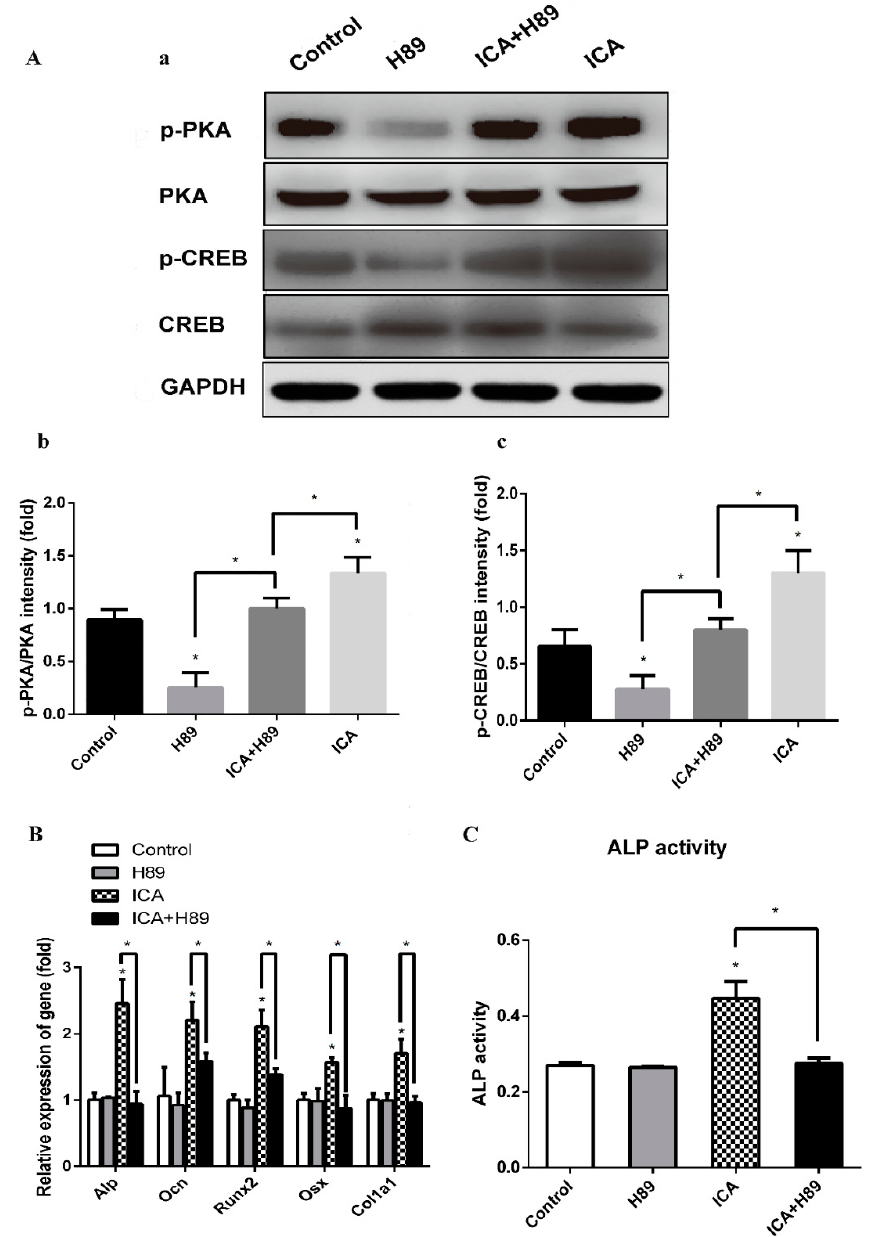
Figure 6. PKA inhibitor (H89) abrogated ICA-prompted osteogenesis via blockade of the cAMP / PKA / CREB signaling pathway. ( A-a ) The protein expression levels of p-PKA, p-CREB, total PKA and CREB treated with / without ICA and H89. ( A-b ) Relative density of p-PKA expression levels. ( A-c ) Relative density of p-CREB expression levels. The mRNA expression levels ( B ) and the ALP activity ( C ) on day 7 of osteogenic induction with / without ICA and H89. Bar represents the mean ± SD ( n = 3). * p <